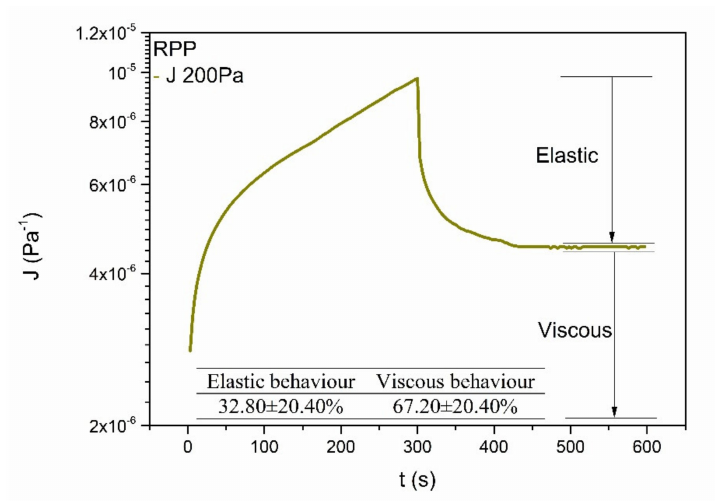
Figure 4. Selected creep and recovery tests showing the evolution of the compliance modulus with time when for M200 sample applying and releasing a constant stress. Inset: Average values of the elastic and viscous components of the sample considering all the different stresses